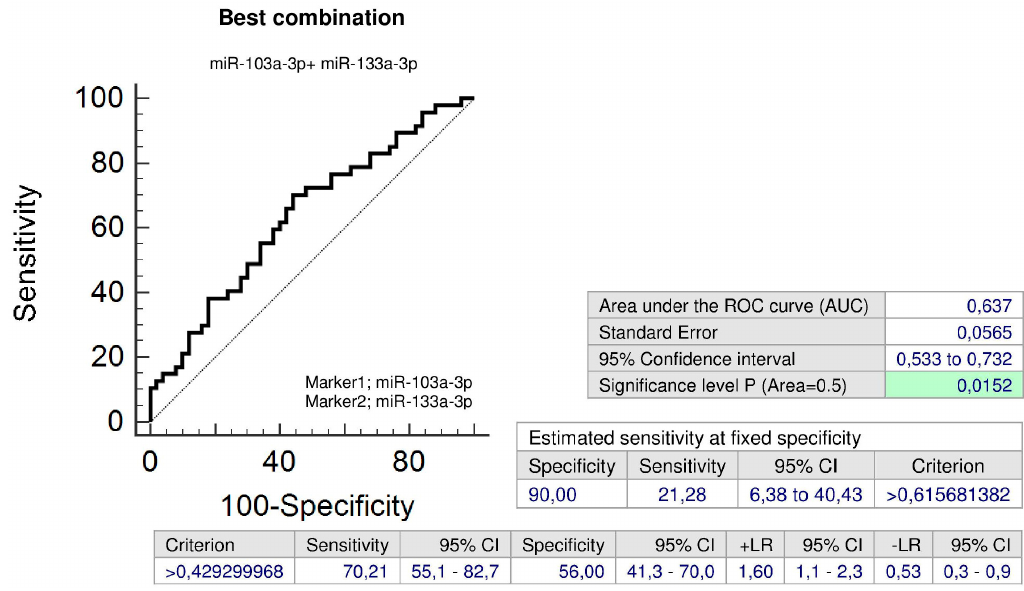
Figure 12. Combined postnatal screening of microRNAs in the identification of children with abnormal postnatal clinical findings descending from severe PE pregnancies. Postnatal combined screening of miR-103a-3p and miR-133a-3p showed the highest accuracy for the identification of children with abnormal clinical findings with a prior exposure to severe PE at a higher risk of later development of cardiovascular/cerebrovascular diseases.